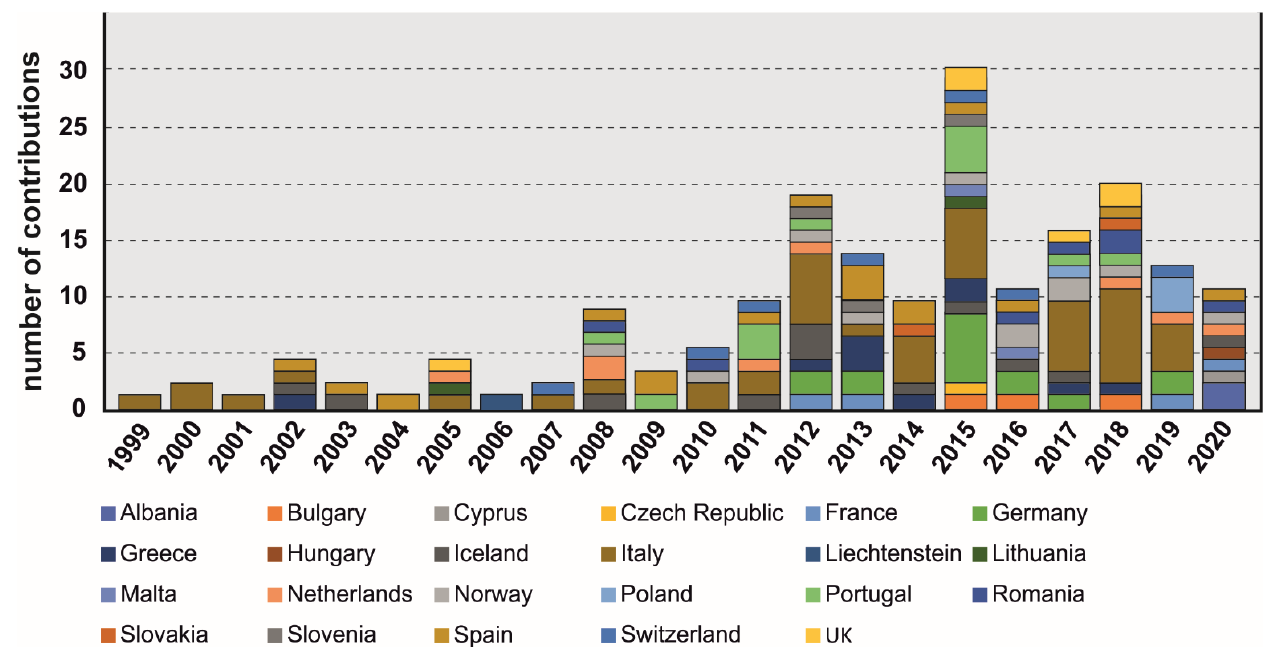
Figure 2. Temporal evolution of the scientific contributions combining GNSS and InSAR data in Europe per country.